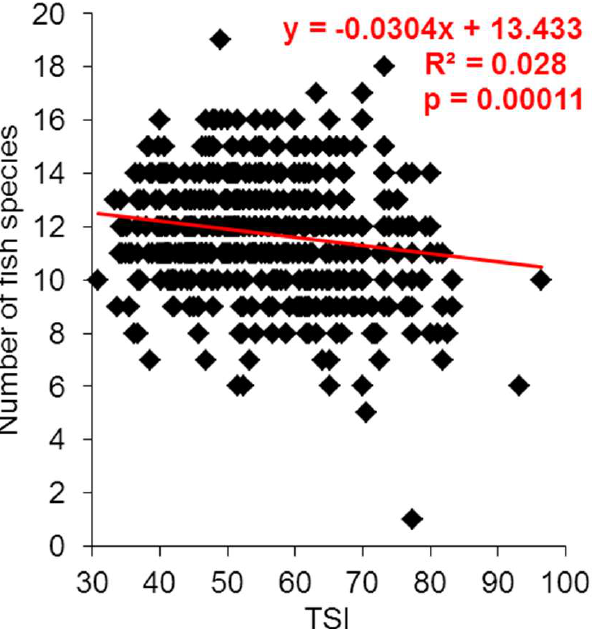
Figure 5. The relationship between the lake trophic state index (TSI) and the number of fish species in 535 Polish lakes.